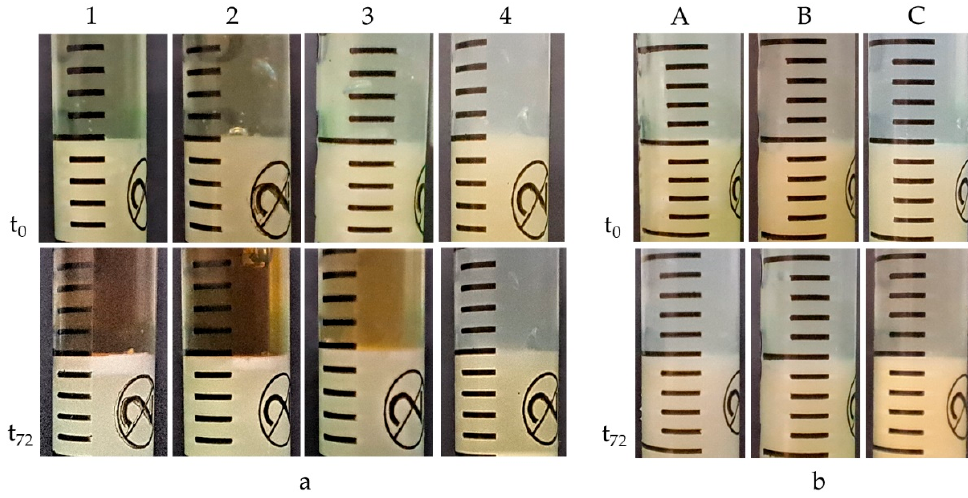
Figure 5. ( a ) Formulations (1–4): visible bright layer of reaction products on the surface of model sebum for samples (1–3) and no reaction for sample 4. ( b ) Formulations (A–C): inactivity of hydrogels against model sebum components.